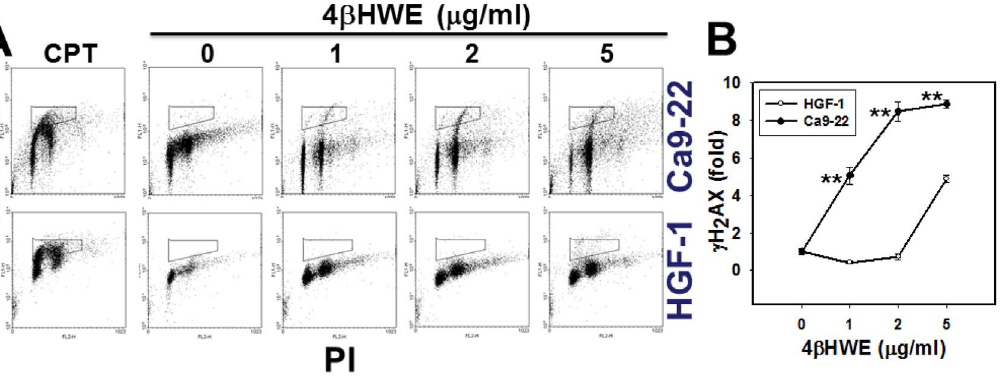
Figure 5. Treatment with 4 b HWE induced different c -H2AX-based DNA damage in oral cancer Ca9-22 cells and in normal oral HGF-1 cells. Cells were treated with 0, 1, 2, and 5 m g/ml of 4 b HWE for 24 h. (A) Representative flow cytometry-based DSB profile for 4 b HWE-treated Ca9-22 and HGF-1 cells. Cells treated with 5 m M camptothecin (CPT) for 24 h were considered c -H2AX positive control. (B) Quantification analysis of fold changes in c -H2AX-based DNA damage in 4 b HWE-treated Ca9-22 and HGF-1 cells. Data, mean 6 SD. The asterisks indicate statistically significant differences between Ca9-22 and HGF-1 cells treated with similar 4 b HWE concentrations ( t -test, P , 0.0005**; n=2 and 3, respectively).